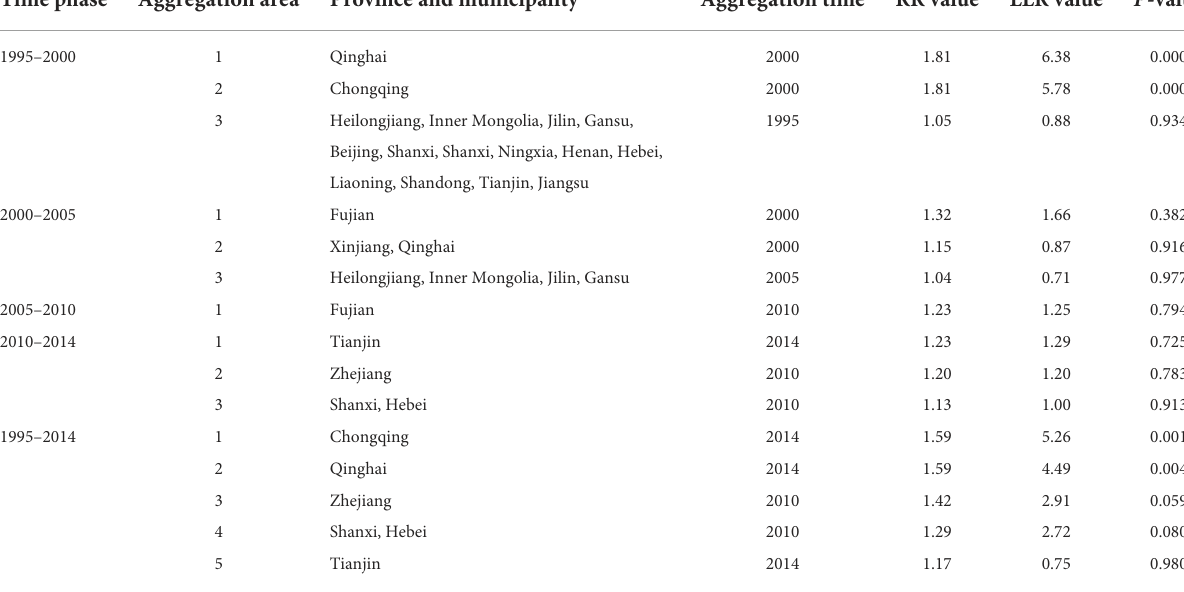
TABLE 4 Temporal and spatial scanning aggregation analysis of myopia prevalence in China from 1995 to 2014. Time phase Aggregation